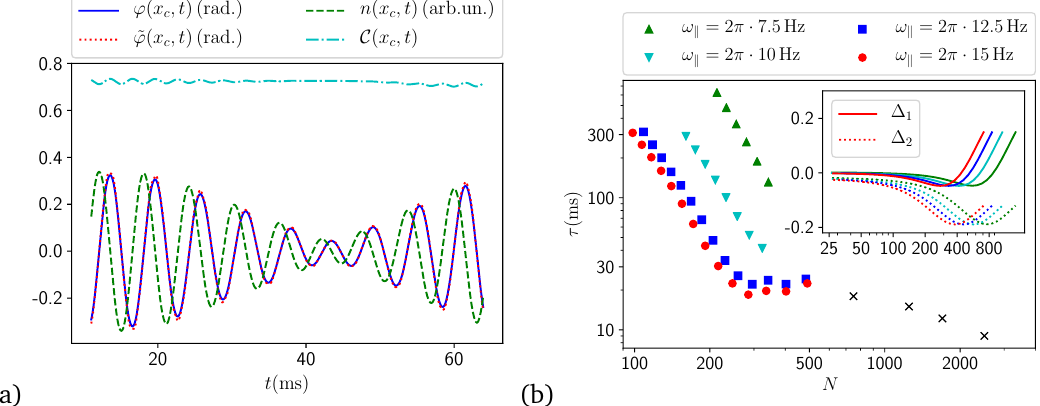
Figure 11: (a) oscillations of relative density n and phase ϕ in the center of the trap = 2 π · 12.5Hz. ˜ ϕ denotes the relative phase ( x = x ) for T = 60K, N = 259 and ω c x ( x , t ) from computed using Choice 2 from Sec. 3. The mean interference contrast C Eq. (39) is also plotted, and is almost constant in time. (b) Big colored dots: damping times extracted from a fit with Eq. (67). Black dots: damping times reported in [ 10 ] . Inset: reproduction of Fig. (4), showing errors ∆ between HF and YY + LDA from 1,2 Eq. (53) for T = 60K.